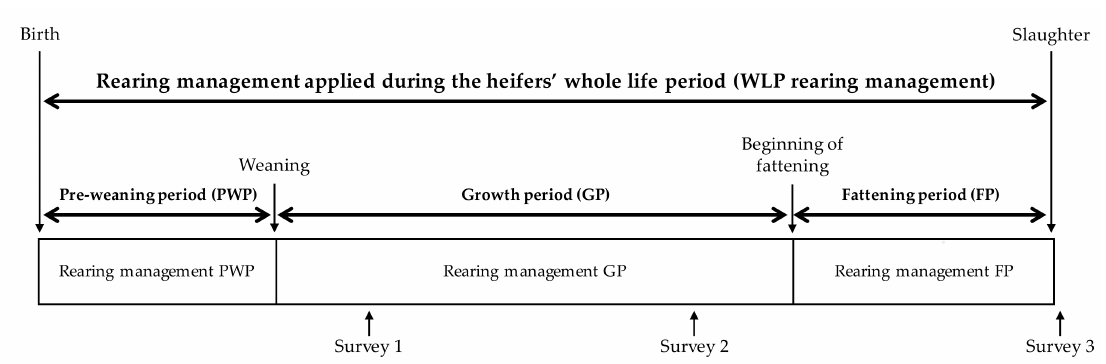
Figure 1. Description of the three key rearing periods during a heifers’ whole life (WLP) and distribution of the three farm surveys conducted over time. Rearing managements characterizing the three key periods (pre-weaning, PWP; growth, GP and fattening, FP) are described in Tables 1–3,